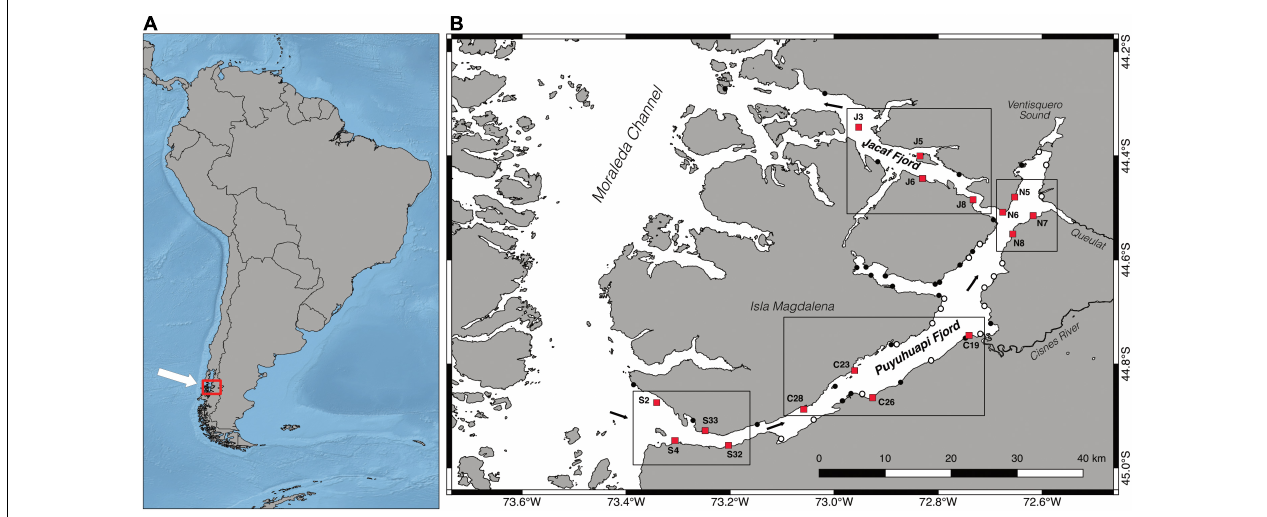
FIGURE 1 | Location of the study area (A) and explored stations (B) . White circles indicate non-cohesive seafloors, black circles indicate rocky bottoms, red squares indicate the stations selected for investigations, and black arrows indicate the main direction of water circulation. Frames and code letters identify the four macro-areas considered in this study: S, southern Puyuhuapi; C, central Puyuhuapi; N, northern Puyuhuapi; and J, Jacaf